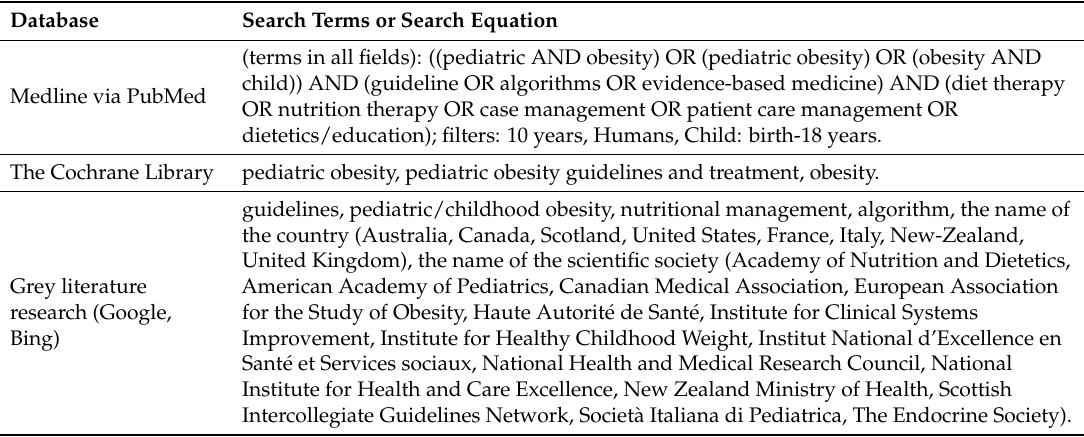
Table 1. Databases and research equations for the systematic review of guidelines on nutritional management of pediatric overweight or